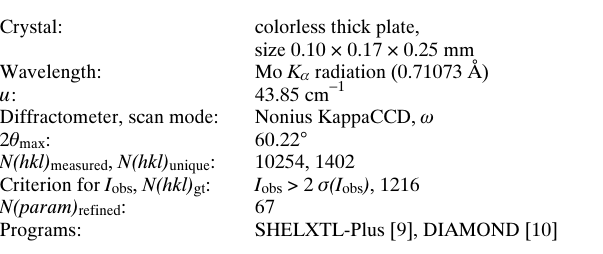
Table 1. Data collection and handling.